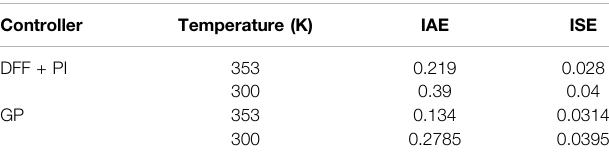
TABLE 4 | IAE and ISE with different